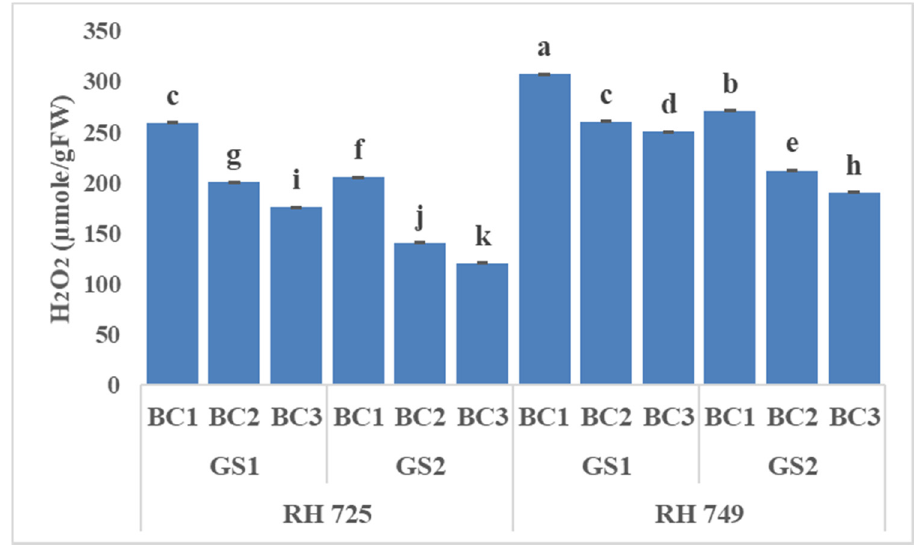
Figure 4. Comparisons of the effects of different concentrations of brassinolide sprays (BC1: control (water spray); BC2: 10 mg BRs/L water; BC3: 20 mg BRs/L water) on the hydrogen peroxidase (H 2 O 2 ) concentration of drought-tolerant (RH 725) and drought-sensitive (RH 749) Indian mustard cultivars at the flower initiation (GS1) and 50% flowering (GS2) stages. Columns marked by different letters indicate significant differences ( p < 0.05) between treatments based on Duncan’s multiple range test. Error bars denote the standard errors of the mean.